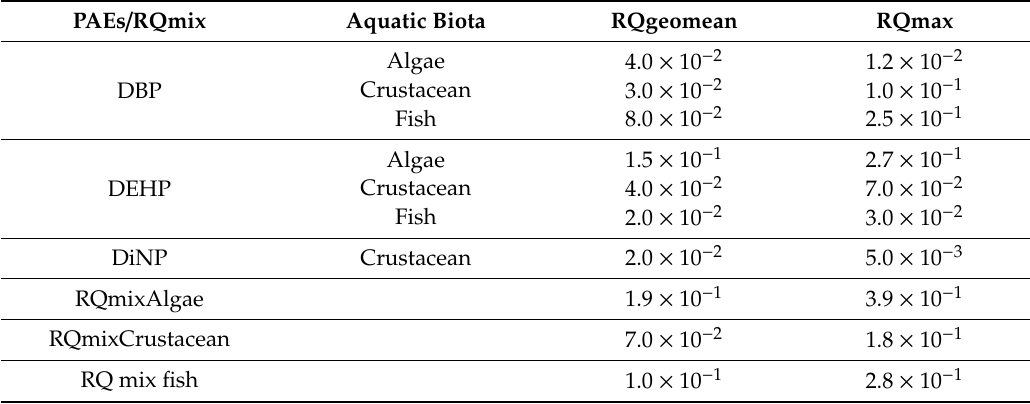
Table 7. Risk Quotient values for individual and mixture PAEs in sediments of U-Tapao